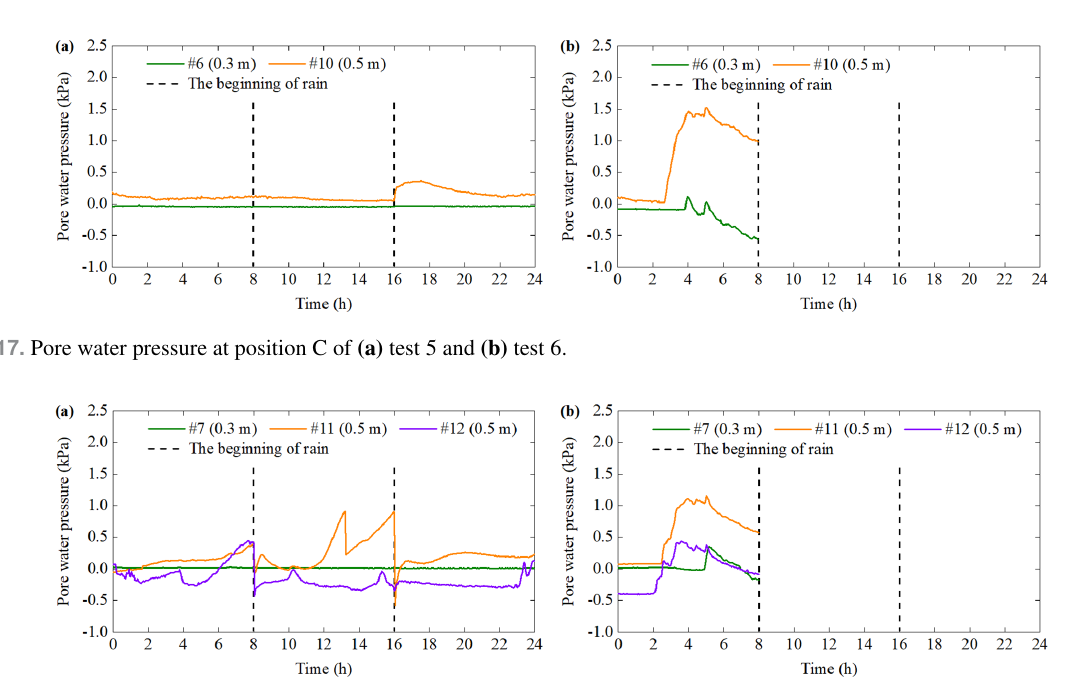
Figure 18. Pore water pressure at position D and E of (a) test 5 and (b) test